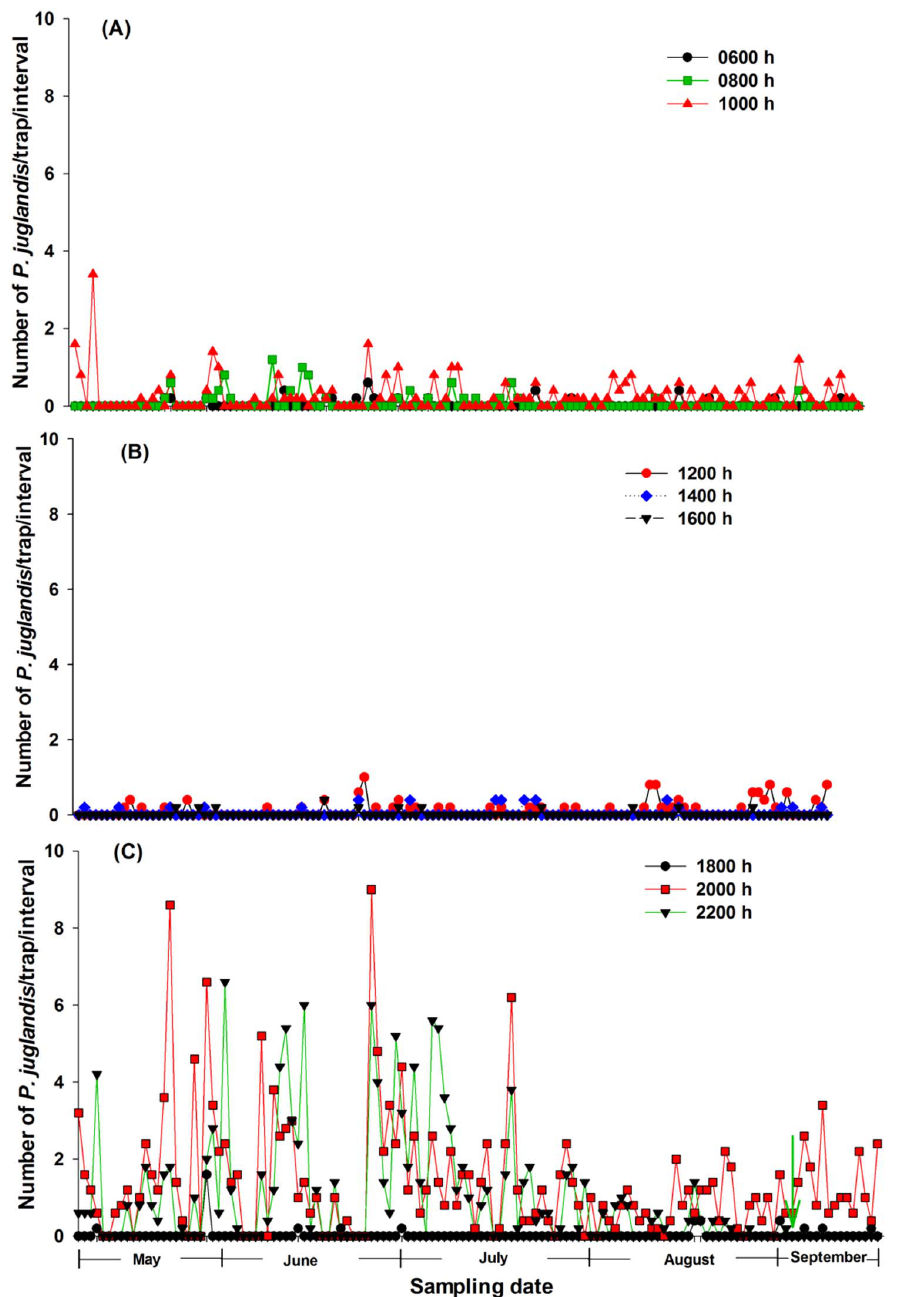
Figure 2. Daily Pityophthorusjuglandis catches from 8 May to 17 September, 2012. (A) 0600–1000 h; (B) 1200–1600 h; (C) 1800–2200 h. Time intervals: 0600 h (2200 h of the previous day–0600 h the current day); 0800 h (0600–0800 h); 1000 h (0800–1000 h); 1200 h (1000–1200 h); 1400 h (1200–1400 h); 1600 h (1400–1600 h); 1800 (1600–1800 h); 2000 h (1800–2000 h); and 2200 h (2000–2200 h). Green arrow points to 3 September, 2012 when P. juglandis flight activity stopped between 2000 and 2200 h for the season. N =133 days.